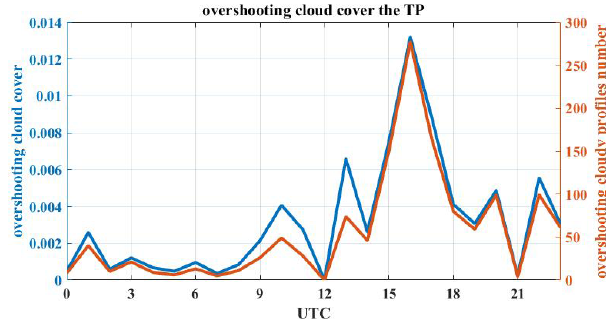
Fig. S3. Over the TP, the averaged cloud cover of